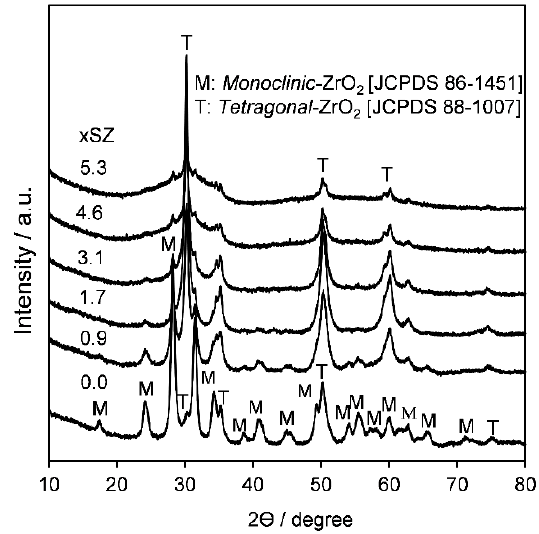
Figure 1. XRD patterns of parent and sulfated zirconia as a function of bulk S loading.